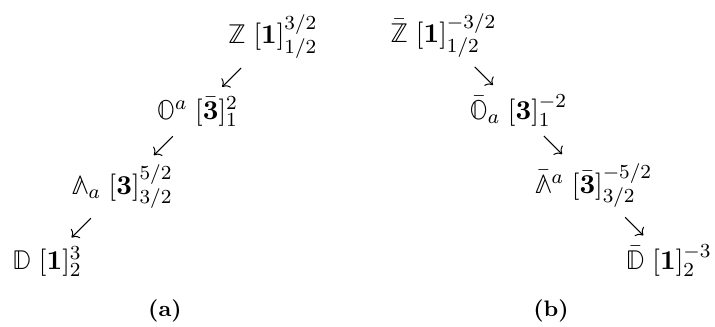
Figure 2. The displacement supermultiplet and its hermitian